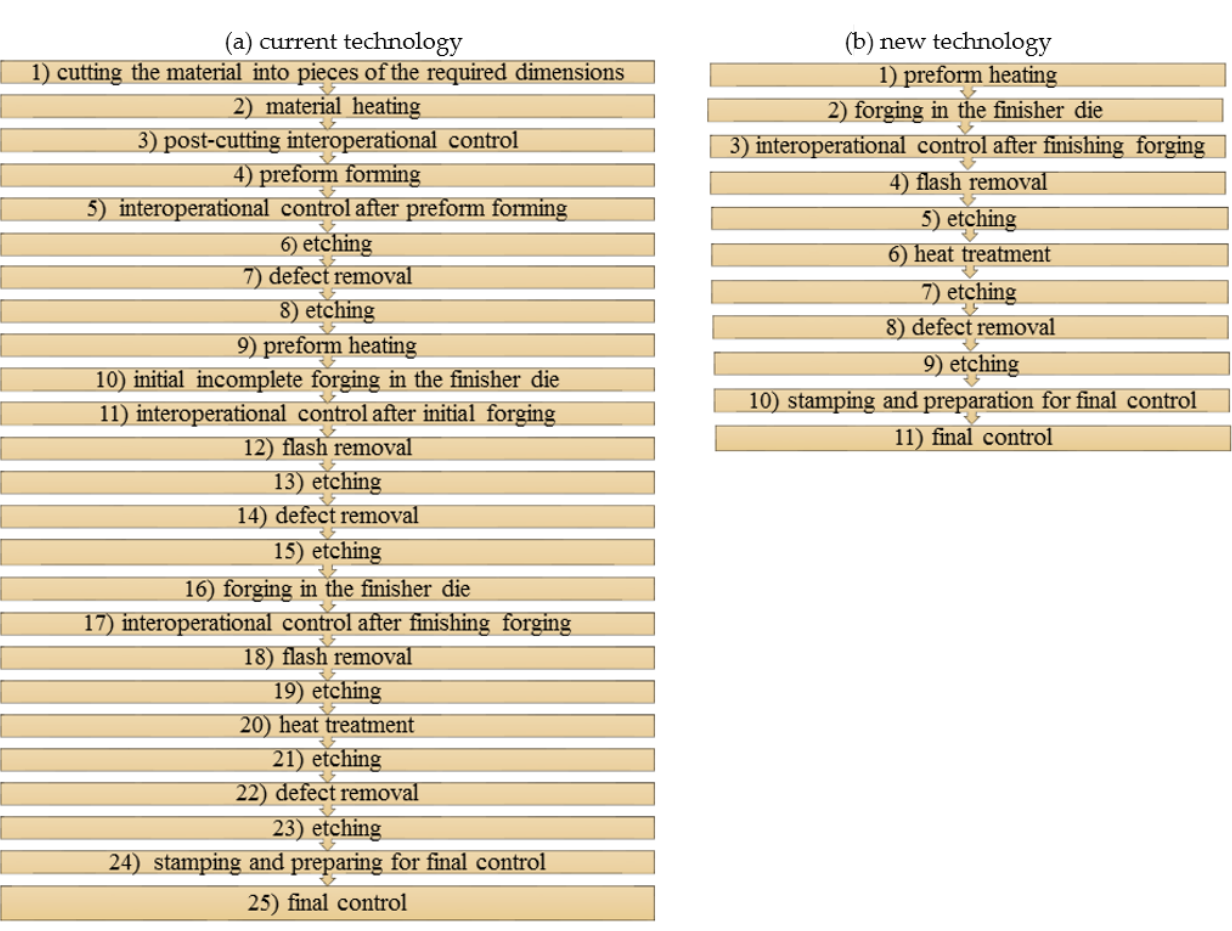
Figure 2. Scheme of the currently applied, multi-stage forging process for high-strength magnesium alloy from an extruded billet ( a ) and the new forming process ( b ).